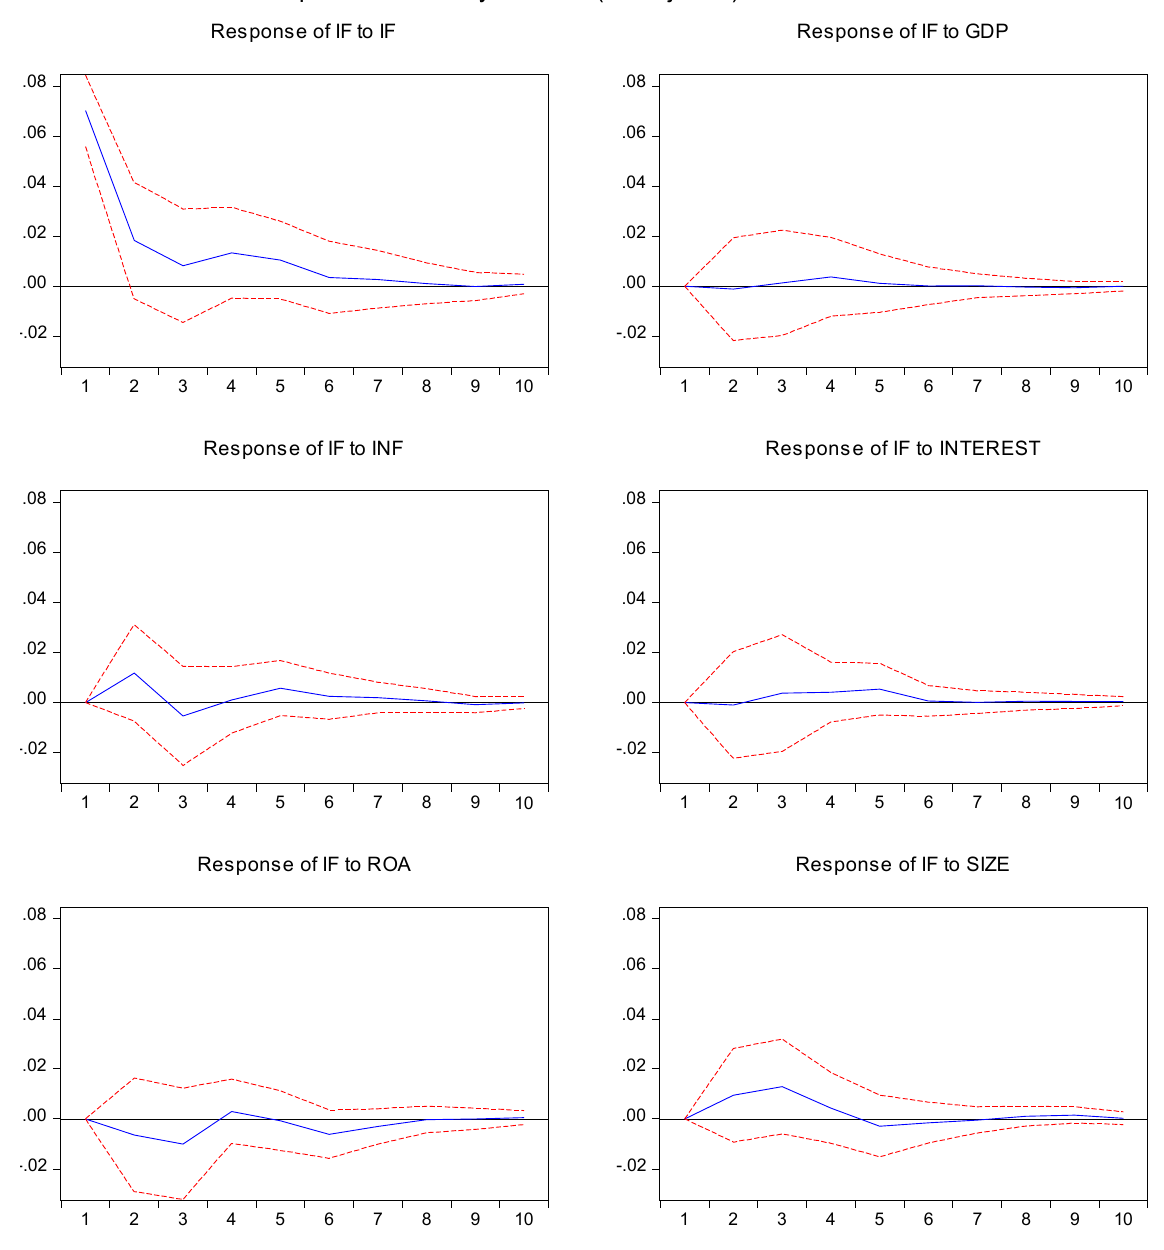
Figure 2. Dynamic responses of financing to the explanatory